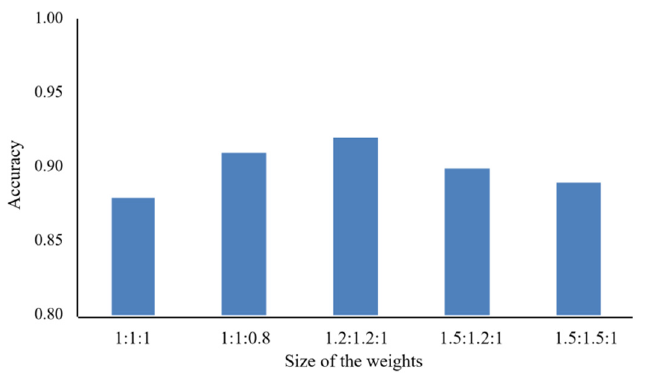
Figure 7. Accuracy of stem rust, leaf rust and healthy wheat at different weighting ratios.